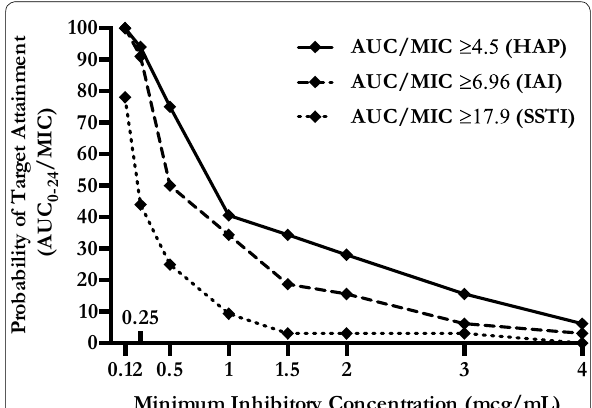
Fig. 2 Probability of target attainment of pharmacodynamics indices in plasma, according to infection types and MIC. HAP: hospital-acquired pneumonia; IAI: intra-abdominal infection; SSTI: skin and soft-tissue infection; AUC: area under the curve; MIC: minimum inhibitory concentration (mcg/mL)